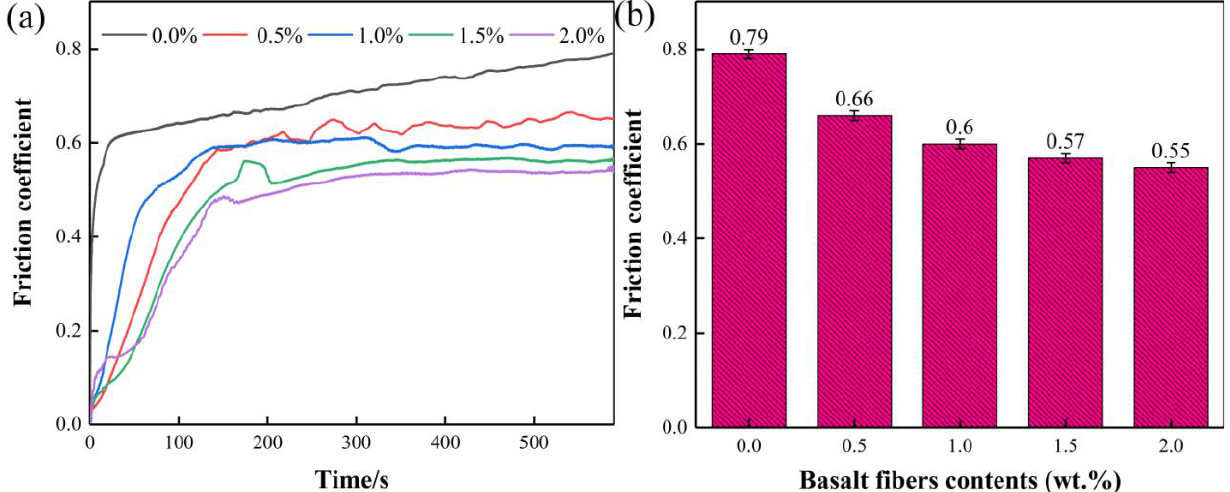
Figure 8. Curves of friction coefficient ( a ) and average friction coefficient ( b ) of composites with different basalt fiber contents.